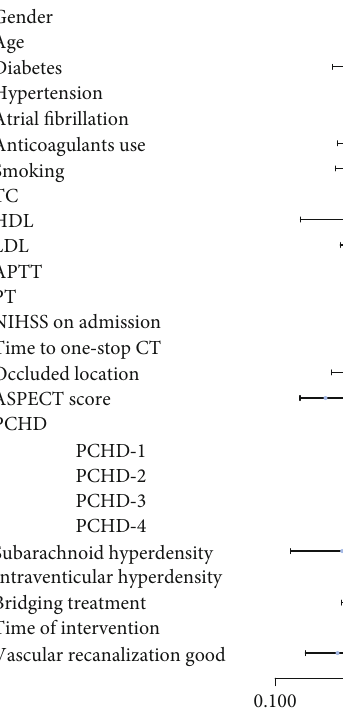
Figure 4: Univariate predictors of